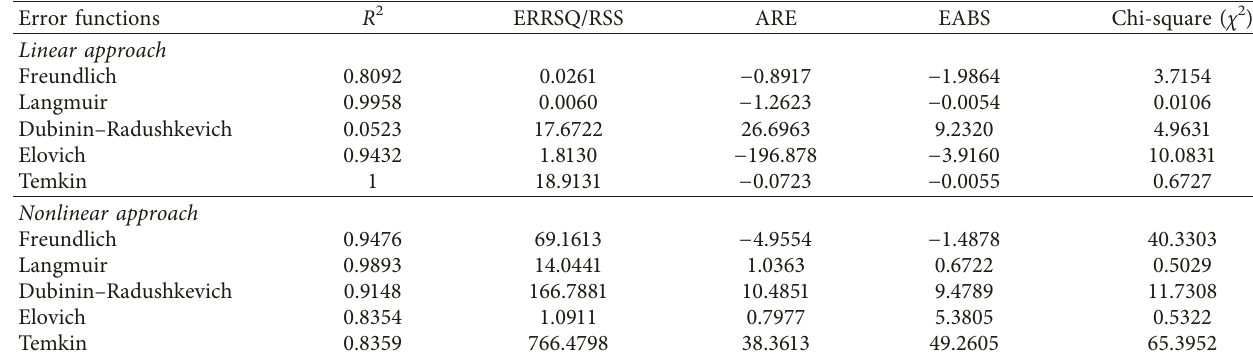
Table 3: Error functions for optimization of equilibrium